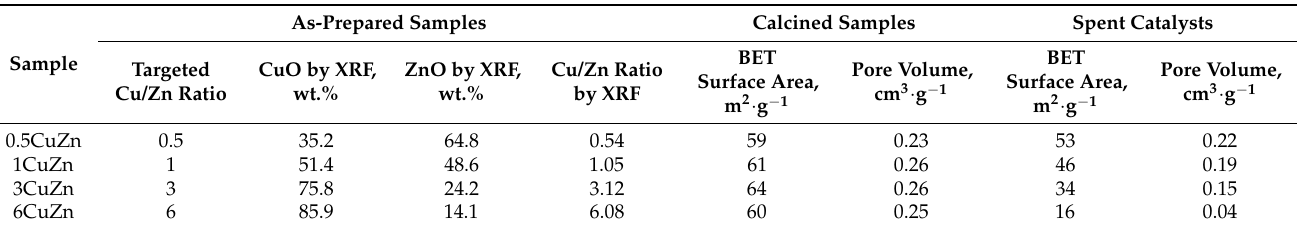
Table 1. The physico-chemical characterization of CuZn as-prepared samples, calcined mixed oxides, and spent catalysts.